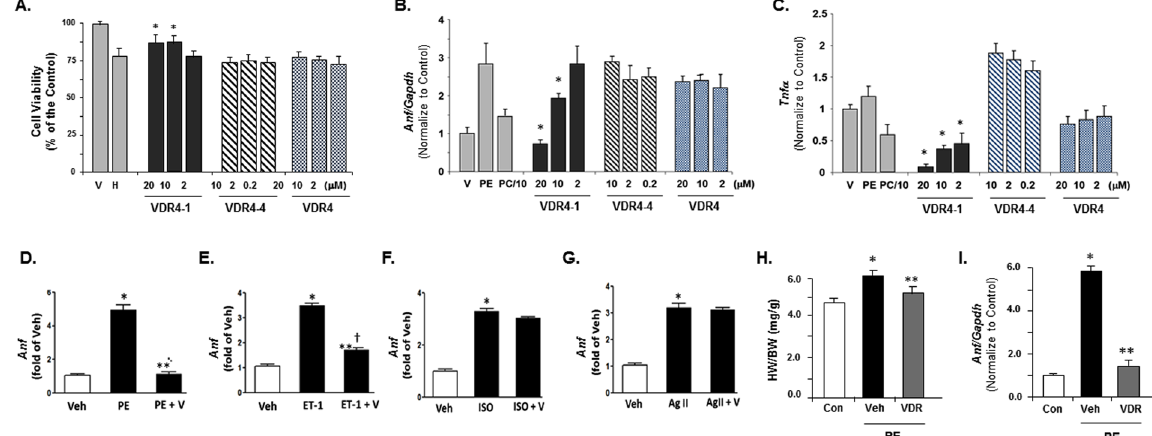
Figure 3. In vitro anti-apoptotic and anti-hypertrophic effect of three lead compounds. ( A ) Cell viability assay of three lead compounds on 294 HEK cells. V = Vehicle, H = H 2 O 2 . * = p < 0.05 vs H. N = 4. ( B,C ) Effect of PE on three lead compounds on Anf ( B ) and Tnf- α ( C ) mRNA expression in ARCM in vitro . mRNA level was determined using real-time PCR. Anf = atrial natriuretic factor, Gapdh = Glyceraldehyde 3-phosphate dehydrogenase, PE = phenylephrine. * p < 0.05 vs PE. N = 4. ( D–G ) Effect of VDR 4-1 on Anf mRNA expression to PE ( D ), ET-1 ( E ), ISO ( F ), and AgII ( G ) in ARCM in vitro . ET-1 = endothelin-1, ISO = isoproterenol, AgII = angiotensin II. * p < 0.05 vs Veh, ** p < 0.05 vs PE or ET-1; N = 4/group. ( H , I ) Heart weight/body weight (HW/BW) ratio ( H ) and Anf mRNA expression ( I ) in mouse hearts after infusion of PE (30 mg/kg/day) via osmotic pump for 7 days. Con = control, Veh = vehicle, VDR = VDR 4-1 (0.6 μμ g/kg). Drugs were injected 3x/ week i.p . * p < 0.05 vs Con, ** p < 0.05 vs Veh; N =